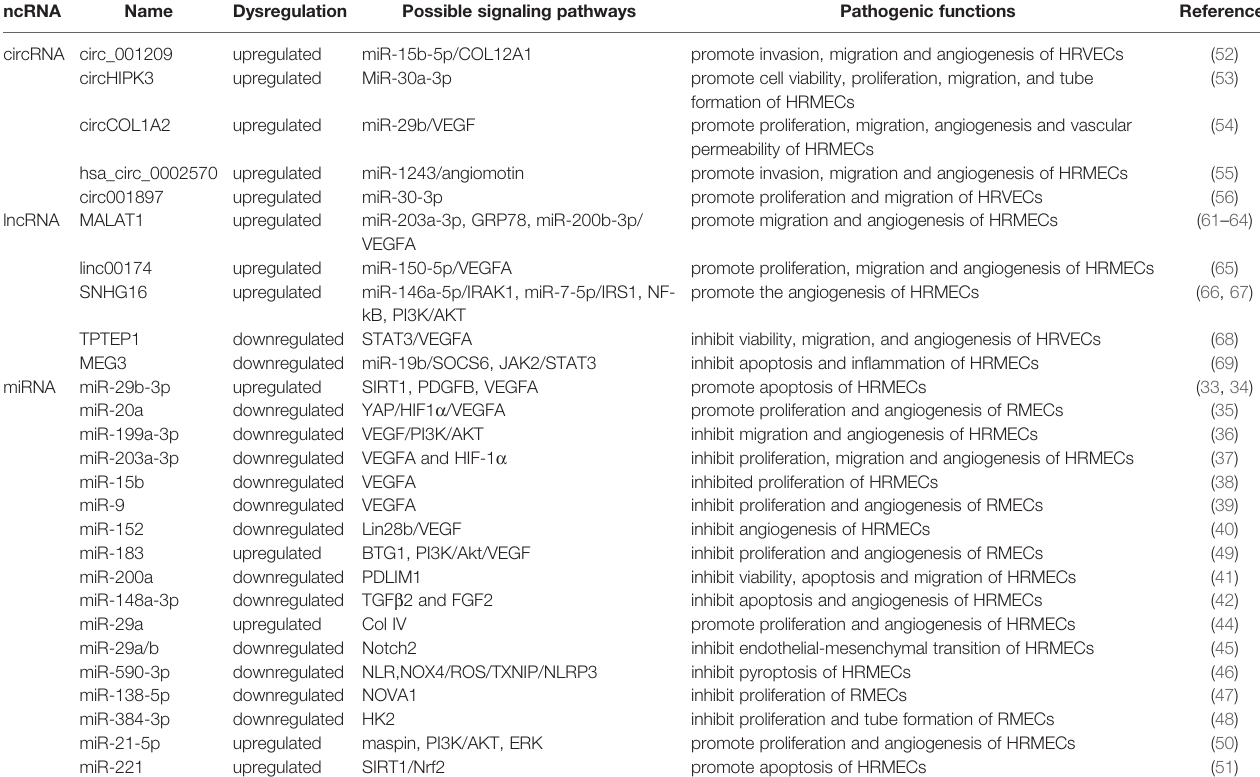
TABLE 1 | The role of miRNA, lncRNA and circRNA in DR and their mechanisms through vascular endothelial cell and